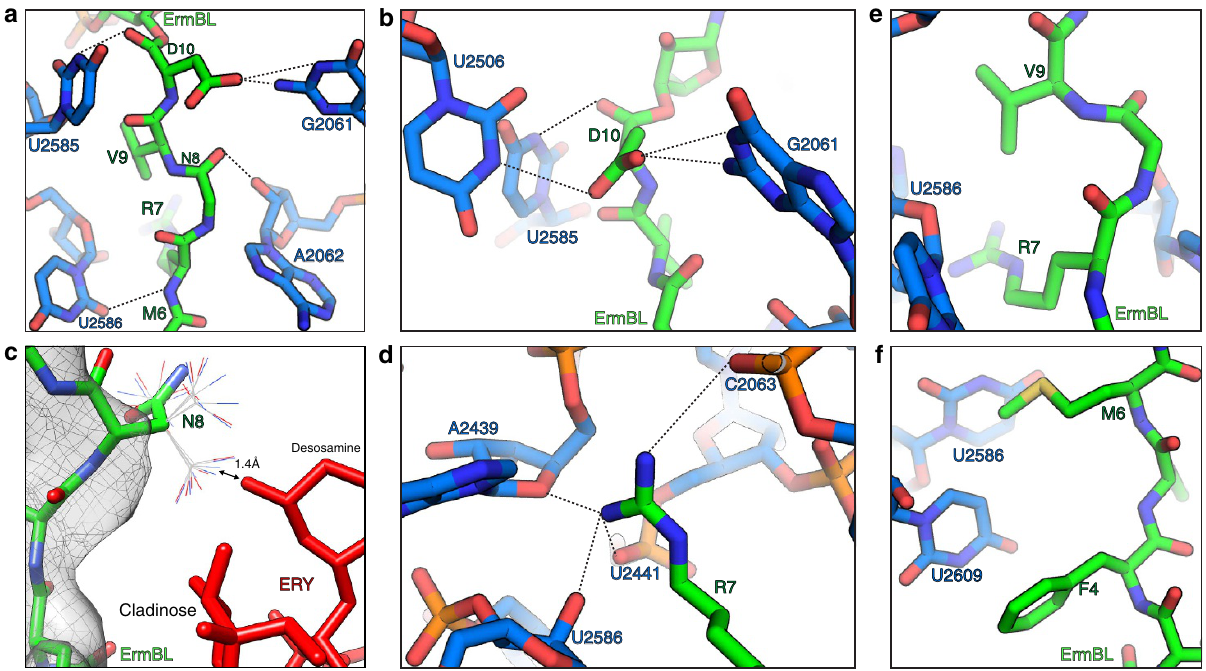
Figure 3 | Interaction of the ErmBL nascent chain within the ribosomal tunnel. ( a – f ) Interactions of ErmBL (green) with 23S rRNA nucleotides (blue). In c , different rotamers of the N8 side chain are illustrated and ERY is shown in